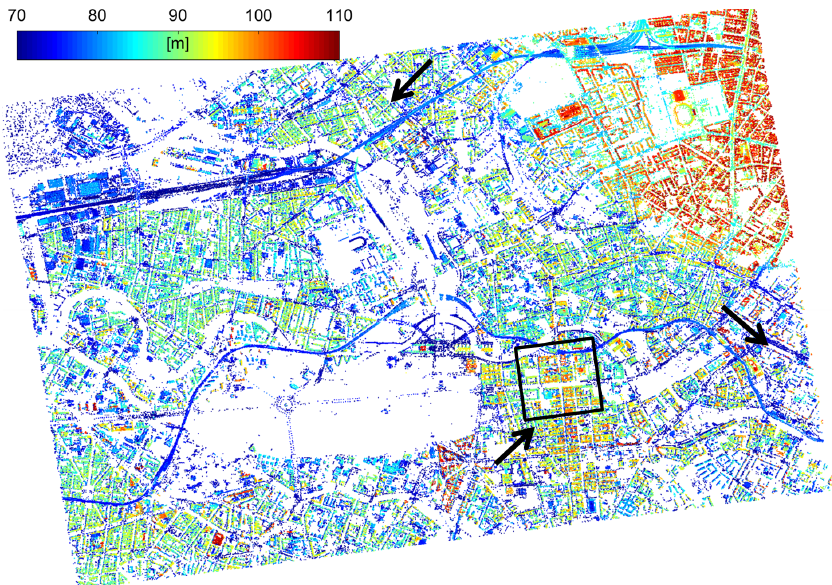
Figure 7. Geocoded PSI point cloud of Berlin, reconstructed from Beam57, in UTM coordinates. The ellipsoidal height is colorcoded. The x - and y -axis correspond to the UTM East and North, respectively. The test sites used for vertical and horizontal accuracy analysis are marked with black rectangle and black arrows, respectively.